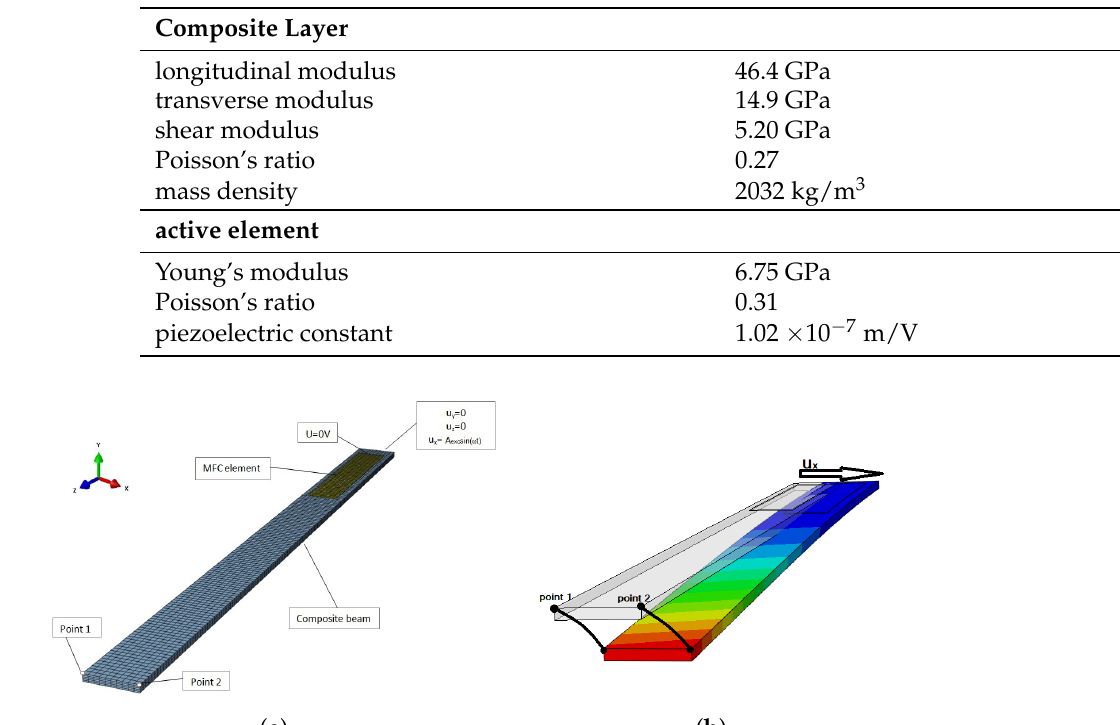
Table 2. The parameters of the structure.